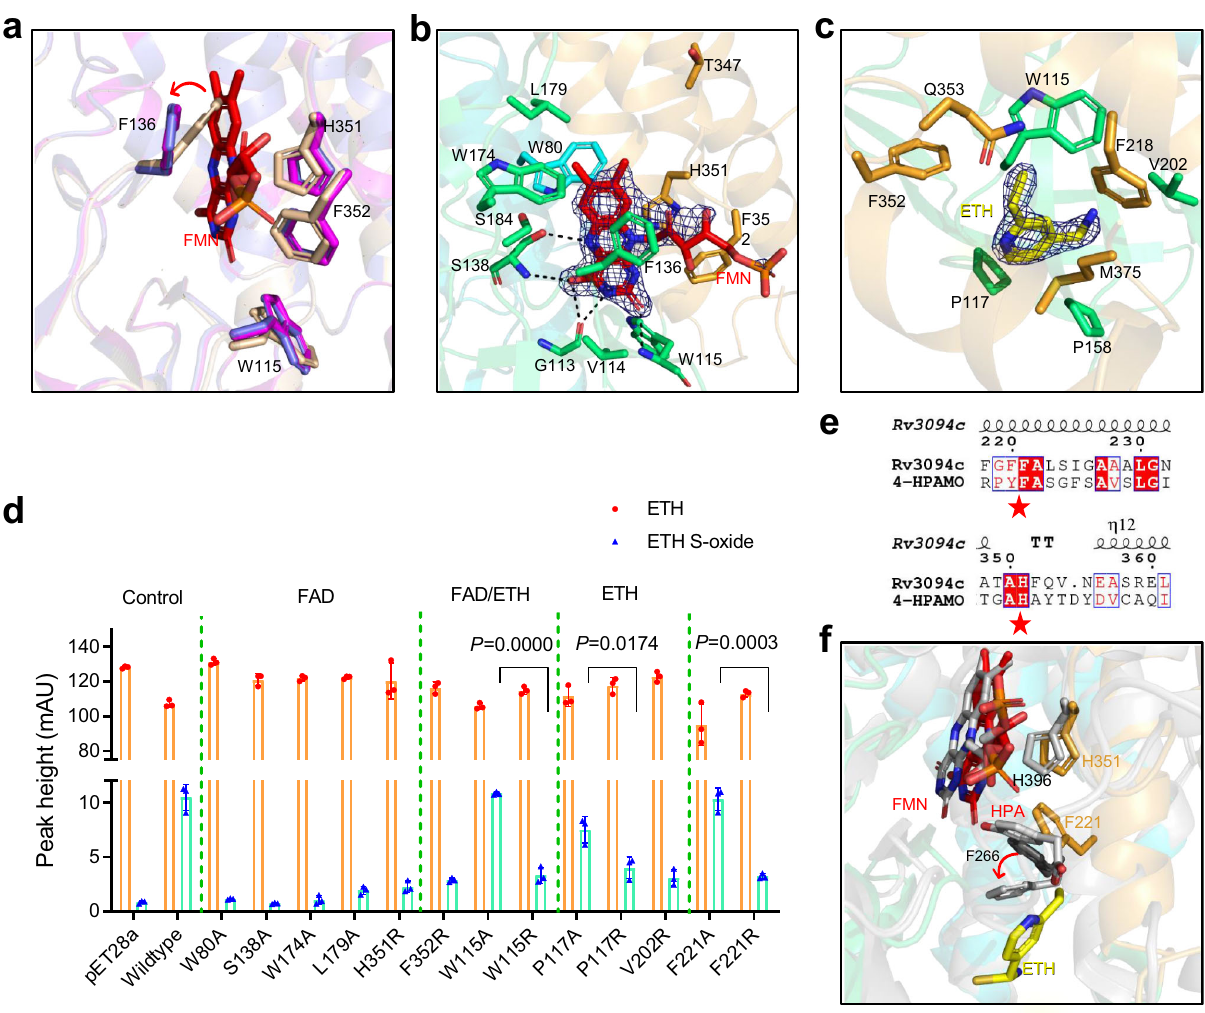
Fig. 6 Structural analysis of the mechanism of Rv3094c-catalyzed activation of ethionamide. a Conformation of residues in the FMN-binding pocket. The four residues of the FMN binding pocket in apo-Rv3094c, Rv3094c-FMN, and Rv3094c-FMN-ETH are colored wheat, magenta, and slate, respectively. FMN is colored red. The red arrow indicates the swinging out of the F136 side chain to create the FMN pocket. b Interactions between FMN and Rv3094c, color-coded as de fi ned in Fig. 5a. The color of each speci fi c amino acid carbon is the same as its domain; the carbon of FMN is shown in red; nitrogen is shown in blue; oxygen is also shown in red. Hydrogen bonds are indicated by dashed lines. The 2Fo-Fc omit map is contoured at the 1.0 σ level. c Interactions between ethionamide and Rv3094c, color-coded as de fi ned in ( b ), except that the carbon of ethionamide is shown in yellow. The 2Fo-Fc omit map is contoured at the 1.0 σ level. d Ethionamide-bioactivation activity of the Rv3094c wild-type protein and its mutants. HPLC-UV peak height was used as a measure of enzyme activity. Controls: empty pET28a vector (negative), wild type Rv3094c (positive). Dashed-green lines separate different groups of mutations: those of residues interacting with FAD and/or ethionamide. Residue F221 may act as a gate separating ethionamide from FMN. Student ’ s t -tests were unpaired, two-tailed. Error bars indicate standard deviation. n = 3 biologically independent experiments. e Sequence conservation analysis of Rv3094c and 4-HPAMO. The alignment of Rv3094c (NP_217610.1) and 4-HPAMO (4-HPA 3-monooxygenase large component, UniProtKB: Q6Q272.1) was generated using Clustal omega and the fi gure was prepared using ESPript (http://espript.ibcp.fr/ESPrip). The secondary structure of apo- Rv3094c is shown above the sequence. Strictly conserved residues are boxed in white on a red background and highly conserved residues are boxed in red on a white background. H396, and F226 in 4-HPAMO and its homologous residues in Rv3094c are marked with red stars. f Conformations of conserved substrate binding sites in Rv3094c and 4-HPA-hydroxylase, colored as de fi ned in ( c ). Gray: 4-HPA-hydroxylase and HPA; F266 of 4-HPA-hydroxylase before HPA binding is shown in